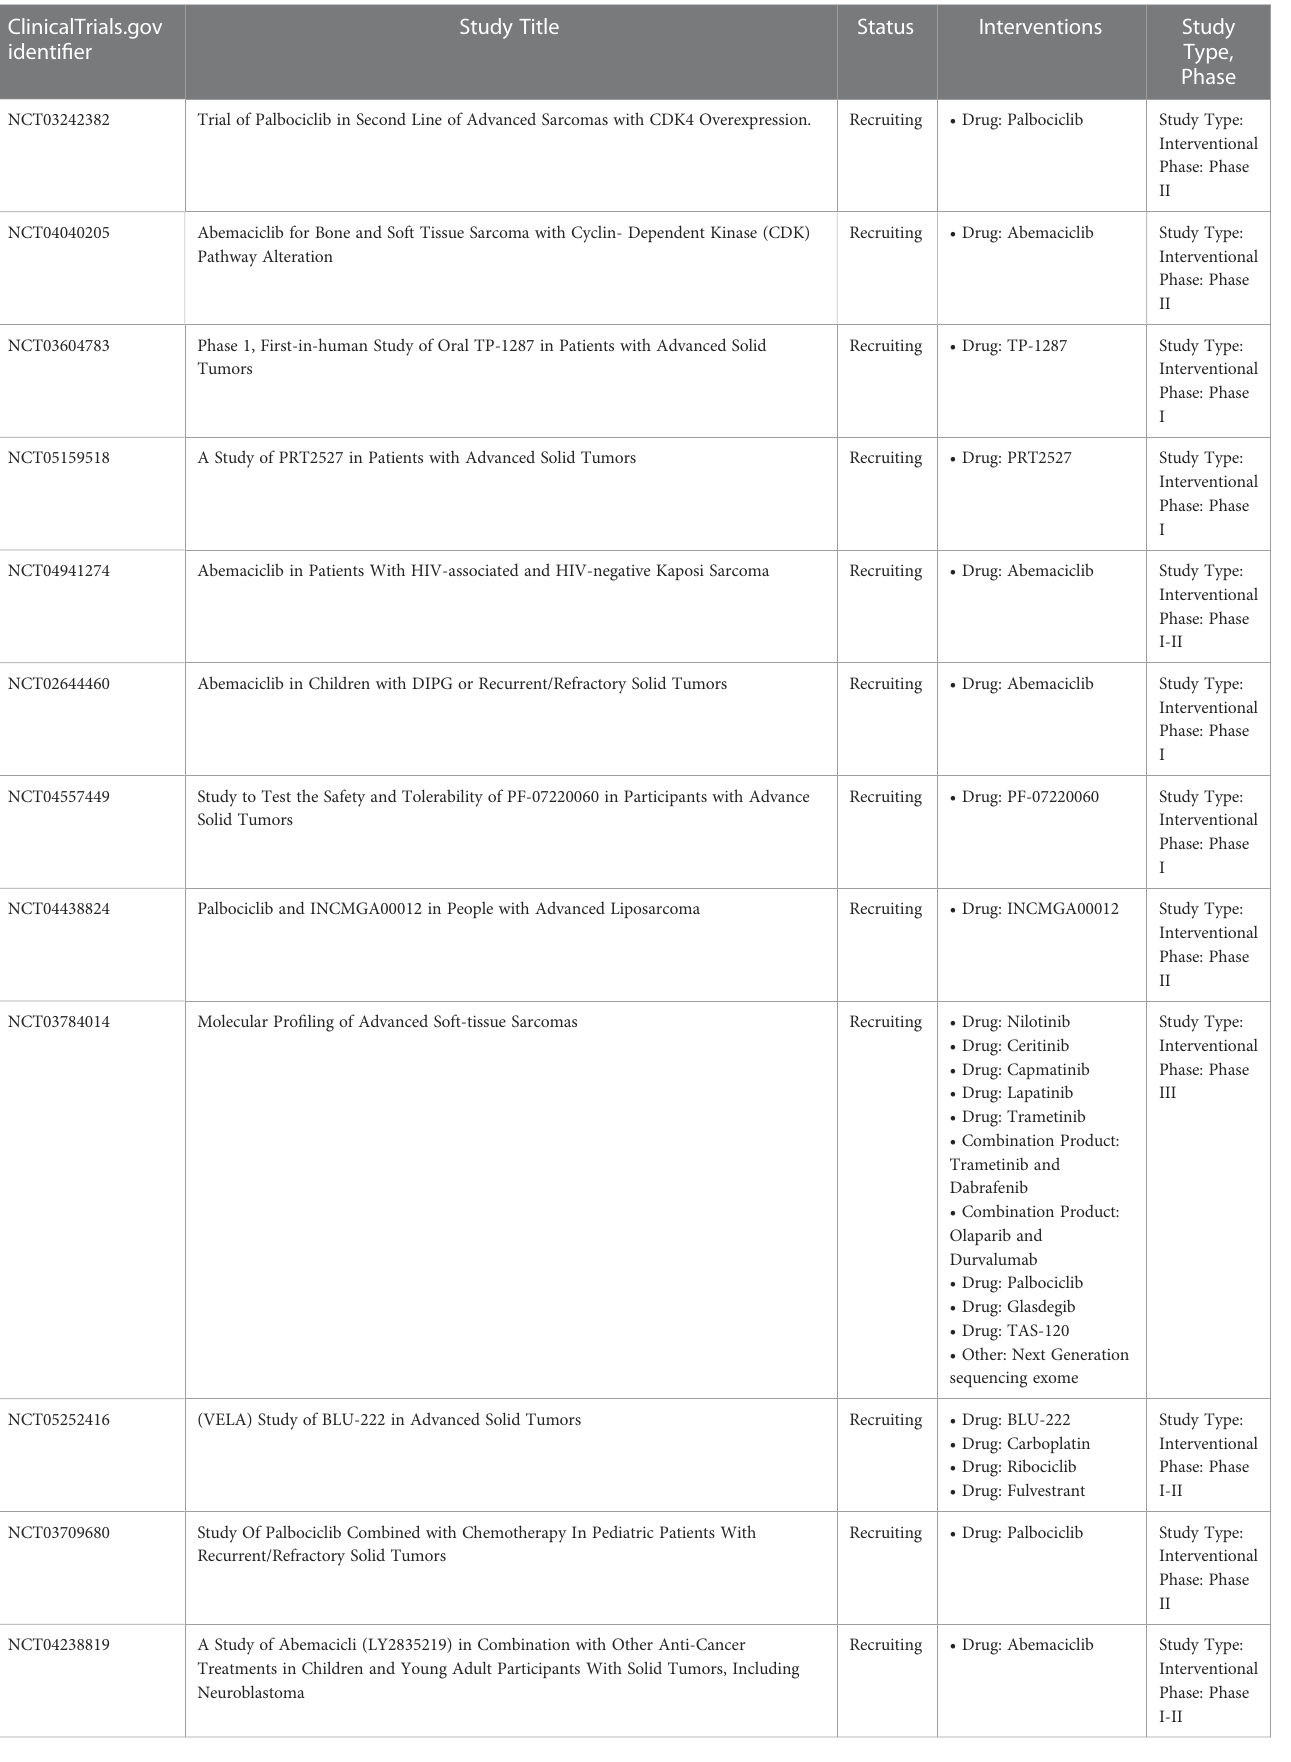
TABLE 1 Ongoing clinical trials with CDKi in BSTS (source: www.clinicaltrials.gov, accessed on October 20 th , 2022). ClinicalTrials.gov identi fi